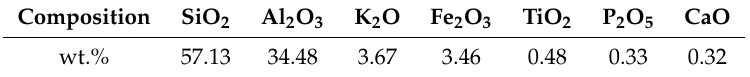
Table 1. Chemical composition (wt.%) of coal fly ash